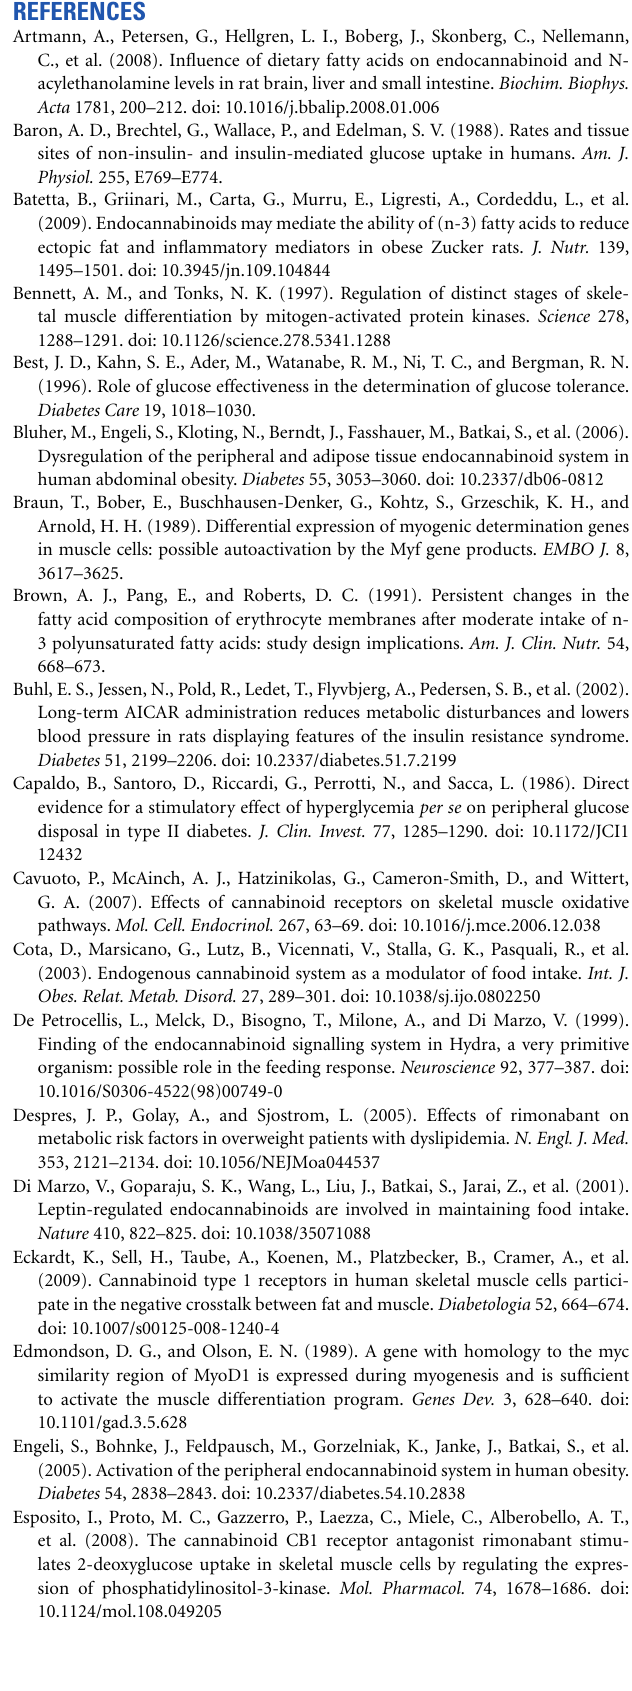
Table S1 | Fatty acid composition of total lipids from proliferating C2C12 cell cultures. Table S2 | mRNA expression in proliferating C2C12 myoblast cultures treated with PUFA and EC. Table S3 | Glucose uptake assay in proliferating and differentiated C2C12 after FA or EC/inhibitor treatments (expressed as relative units of